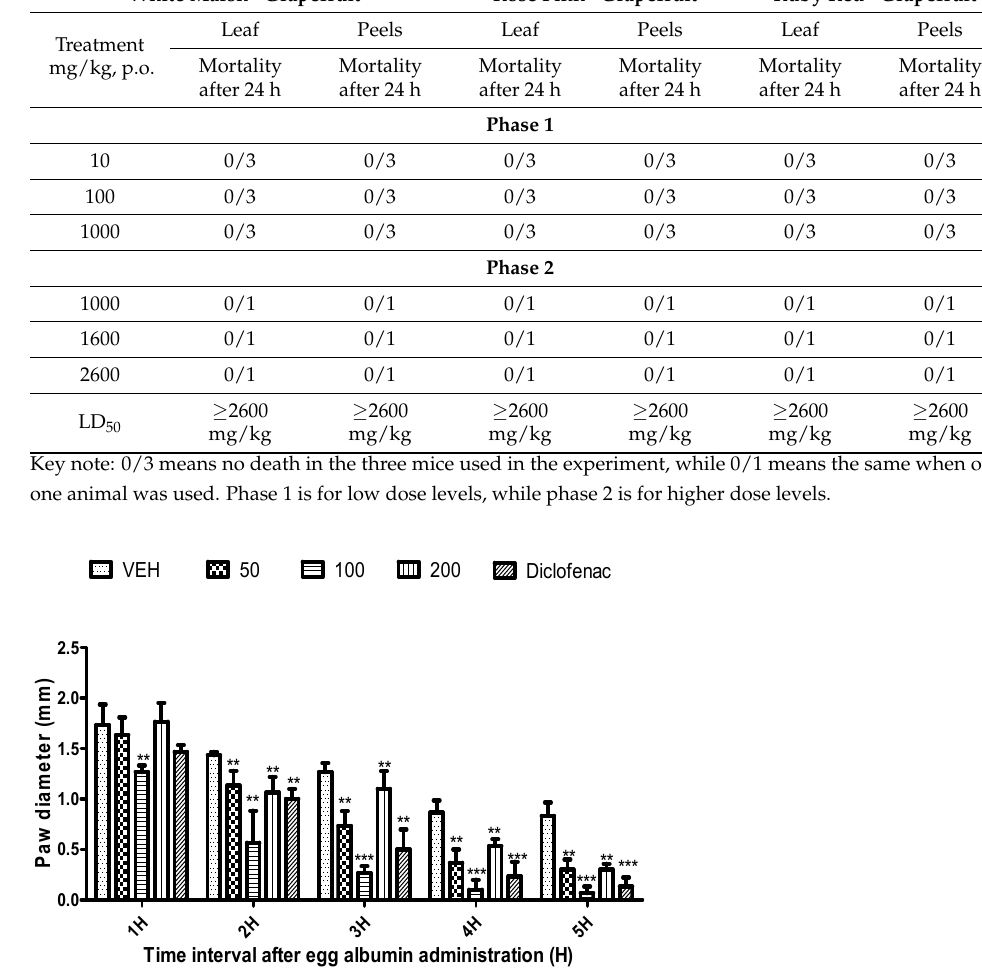
Figure 1. Effect of “White Marsh” grapefruit ( C. paradisi ) fresh peel essential oil on egg albumin- induced rat paw oedema. Results are expressed as Mean ± SEM. VEH, ECH and ASA represent vehicle (5% Tween 80), Marsh peel essential oil (FMPG) and diclofenac, respectively. ** p < 0.01, *** p < 0.001, statistically different from negative control group (ANOVA, Dunnett’s).